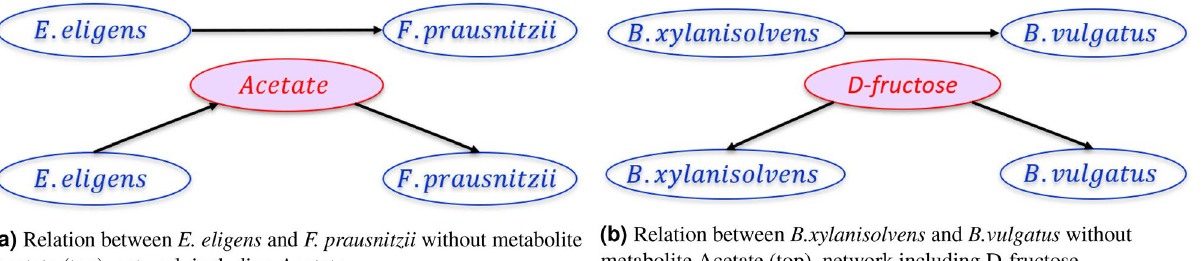
Figure 8. Unrolling causal relationships via metabolites. The presence of metabolites can make two causally dependent taxa conditionally